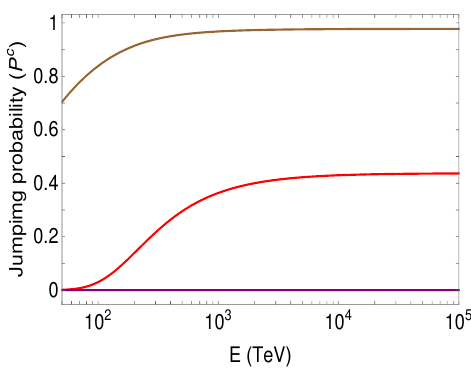
from mass state i to j at resonance vs. neutrino energy. The ij and P c for a = 10 − 5 pc respectively. The purple line represents 31 32